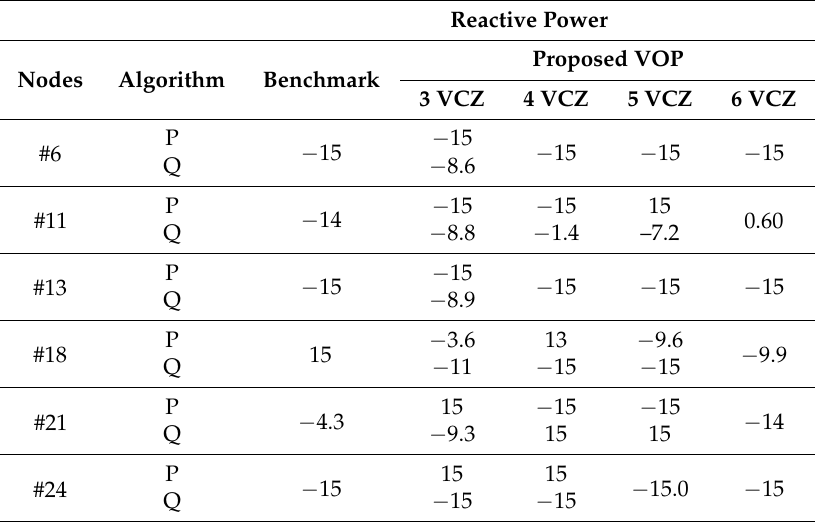
(kVAr) for Case R —DG. ref , i